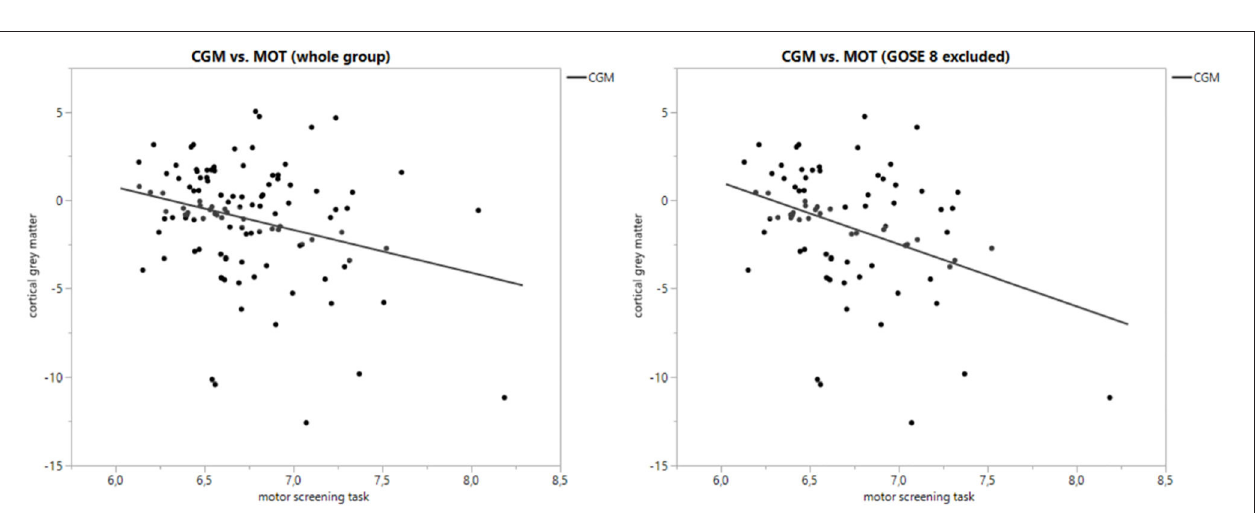
FIGURE 2 | Scatter plot of cortical gray matter atrophy rate (%) vs. motor screening task with whole patient group and